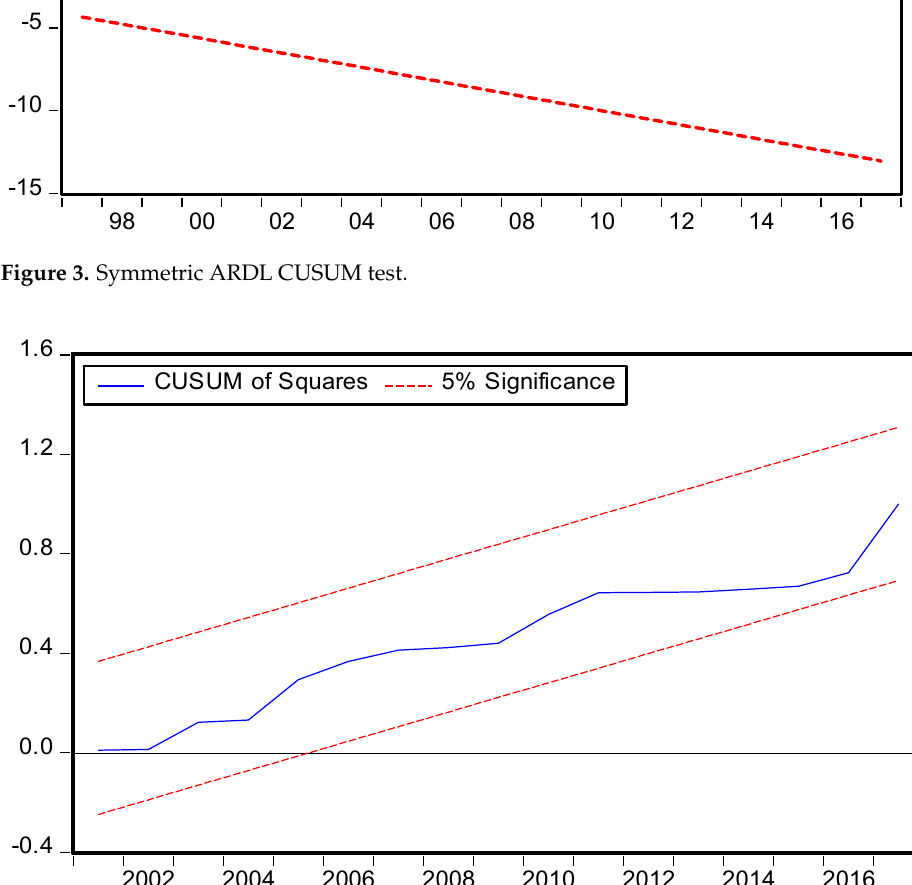
Figure 4. Symmetric ARDL CUSUM Squares test.